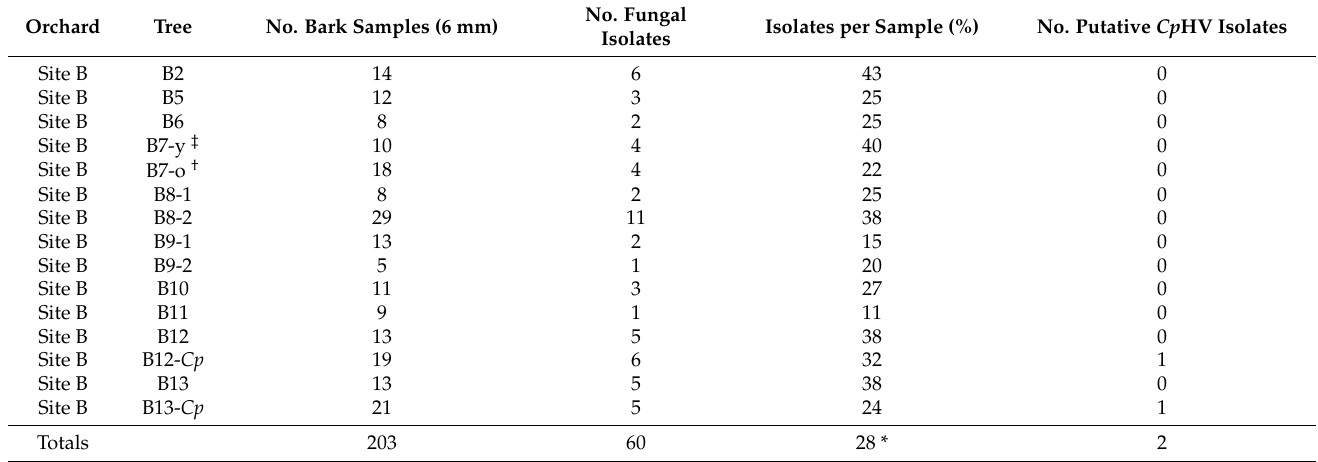
Table 3. Secondary samples and isolates from 2017. Two days after plating on